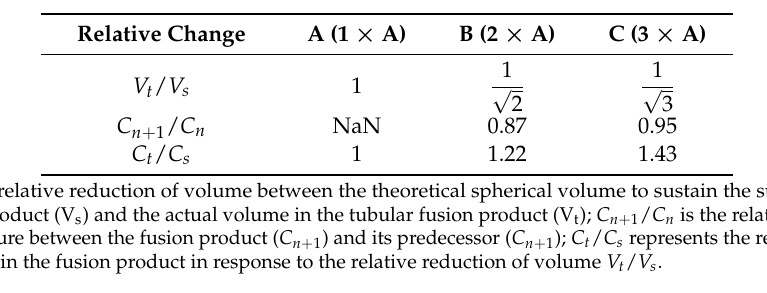
Table 1. Preservation of mean curvature in tubular carriers of less volume.